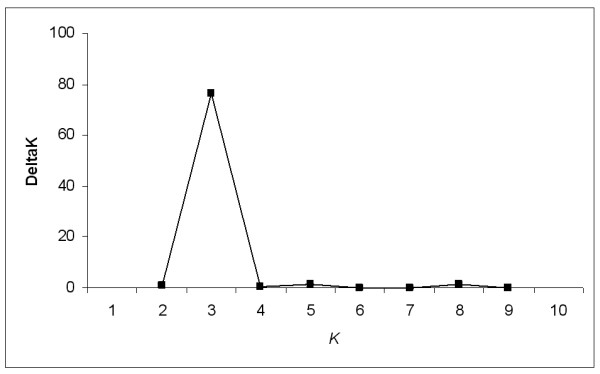
Values of ΔK, with its modal value detecting a true K of 3 groups (K = 3).